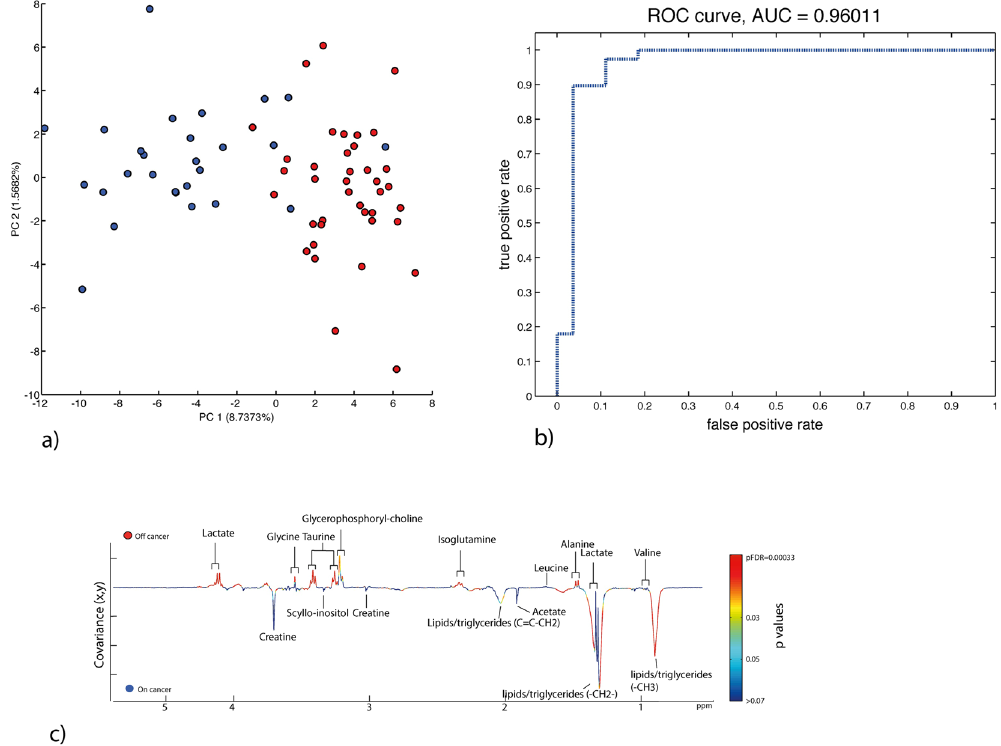
Figure 4. High Resolution – Magic Angle Spinning (HR-MAS) Nuclear Magnetic Resonance (NMR) analysis of mucosal metabolism using orthogonal partial least squares discriminant analysis. ( a ) Cross validated scores plot using Maximum Margin Criteria, and a leave one patient out validation. ( b ) The corresponding ROC curve demonstrating the diagnostic accuracy of the model (AUC 0.96). ( c ) Pseudo-loadings ANOVA plot of the MMC cross validated model, demonstrating co-variance of metabolites between on and off cancer sampling points. The colour code provides a visual description of FDR p values for each signal. Peaks point in the direction of the tissue state with which they are positively associated (up or down) and signals red in colour have greater statistical significance.